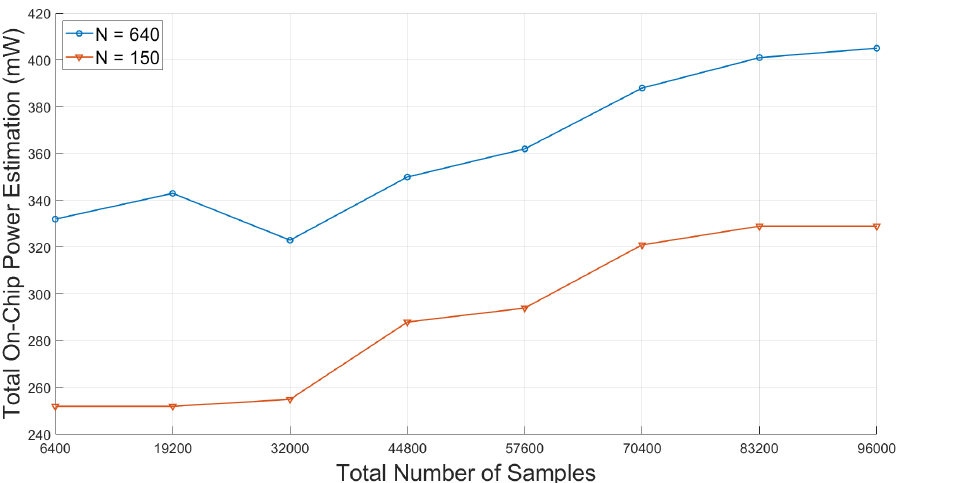
Figure 20. Power estimation for the proposed architecture using the same amount of samples for image with width equal to 640 and 150, shown in blue and red lines,